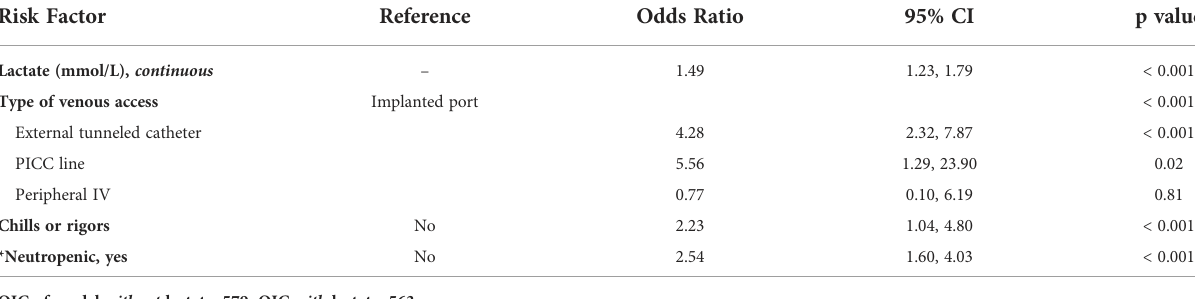
TABLE 3 Occurrence of ≥ 1 invasive bacterial infection (IBI) within 48 hours, adjusted odds by risk factor (results of multivariable analysis). Risk Factor Reference Odds Ratio